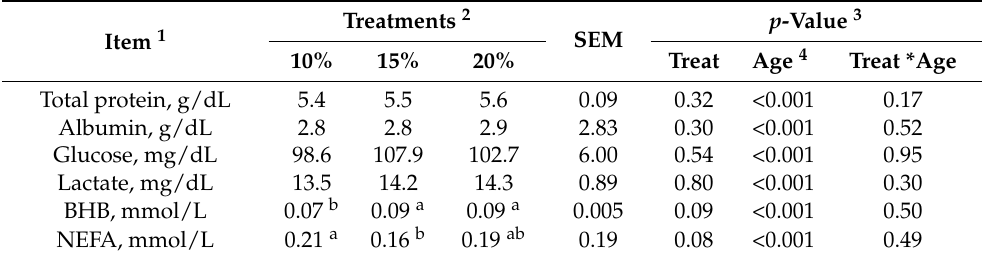
Figure 3. Preweaning starter intake of dairy calves previously fed different volumes of colostrum. 10% BW as colostrum (n = 10); 15% BW as colostrum (n = 10); 20% BW as colostrum (n = 10). Age effect ( p < 0.001) and treatment by age interaction effect ( p = 0.08). Table 3. Blood metabolite concentrations of dairy calves fed different volumes of colostrum at birth.